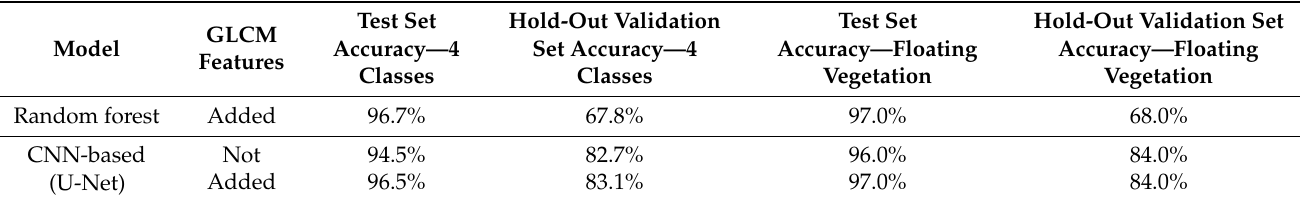
Table 2. Summary of model results on test set and hold-out validation